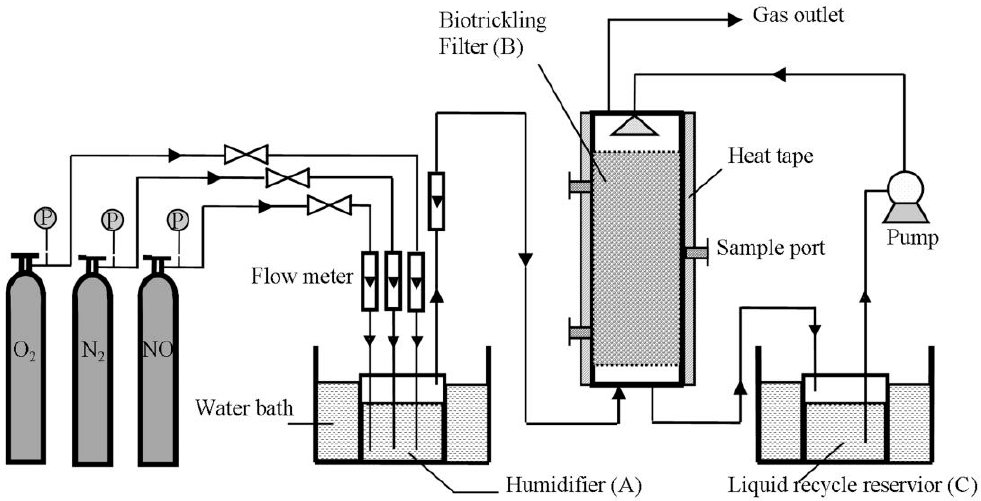
Figure 1. Experimental setup of a biotrickling filter system.